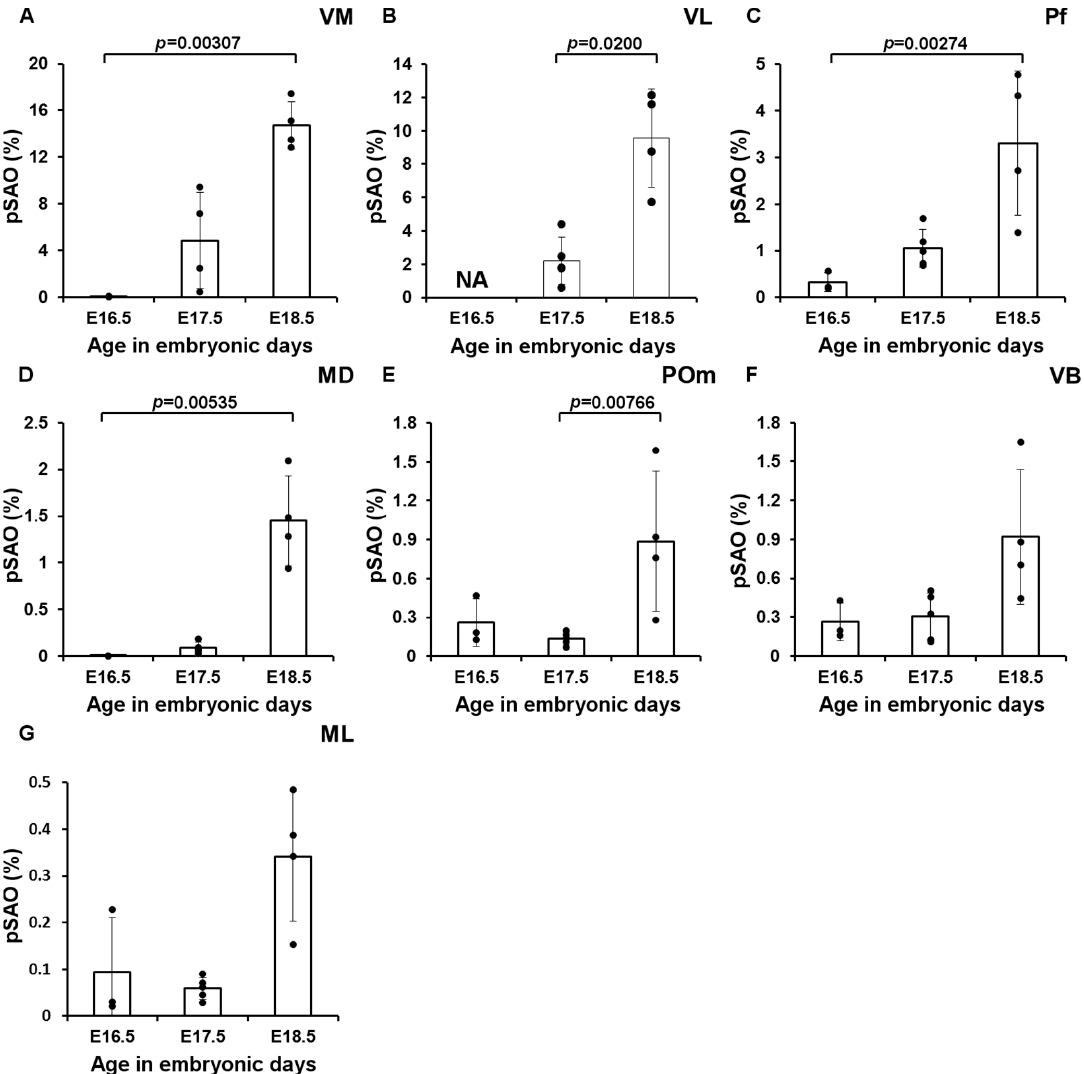
Figure 9. RFP signal quantification in the thalamic nuclei. Percentage of summed area occupied by above-threshold RFP-signal (pSAO). ( A ) VM (E16.5, n = 3, E17.5, n = 4, E18.5, n = 4), ( B ) VL (E16.5, n = 0, E17.5, n = 4, E18.5, n = 4) ( C ) Pf (E16.5, n = 3, E17.5, n = 5, E18.5, n = 4), ( D ) MD (E16.5, n = 2, E17.5, n = 5, E18.5, n = 4), ( E ) POm (E16.5, n = 3, E17.5, n = 5, E18.5, n = 4) ( F ) VB (E16.5, n = 3, E17.5, n = 5, E18.5, n = 4), ( G ) ML (E16.5, n = 3, E17.5, n = 5, E18.5, n = 4). Since the VL could not reliably be